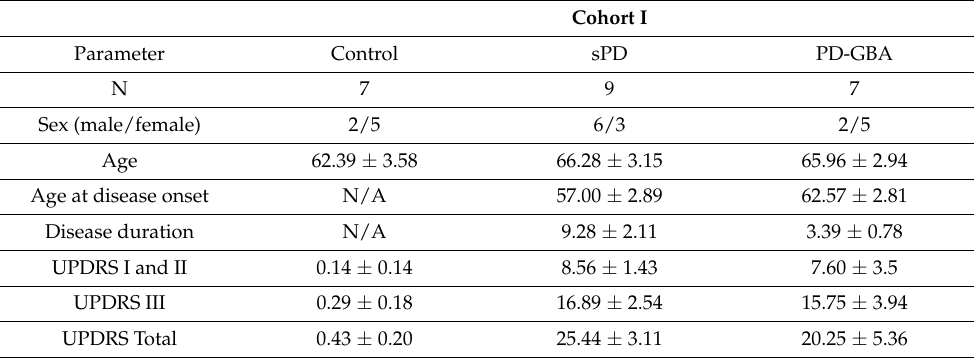
Table 1. Patient demographics and clinical assessment of sPD and PD-GBA patients in Cohort